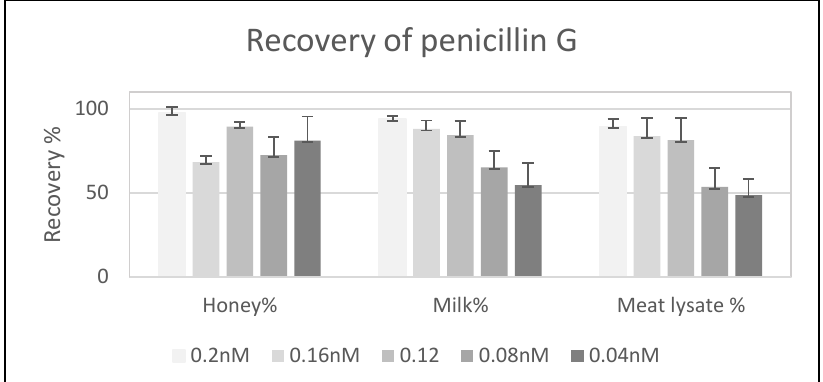
Figure 4. Recovery percentages of penicillin G in different matrixes. Concentrations (0.04 nM, 0.08 nM, 0.12 nM, 0.16 nM, and 0.2 nM) of the antibiotic added to samples of honey (first column group), defatted milk (second column group), and meat lysate (Third column group). The recovery (%) is calculated based on the indirect measurement of the bounded antibiotic to 6His-PBP2x* tagged protein using real-time biosensor assay.